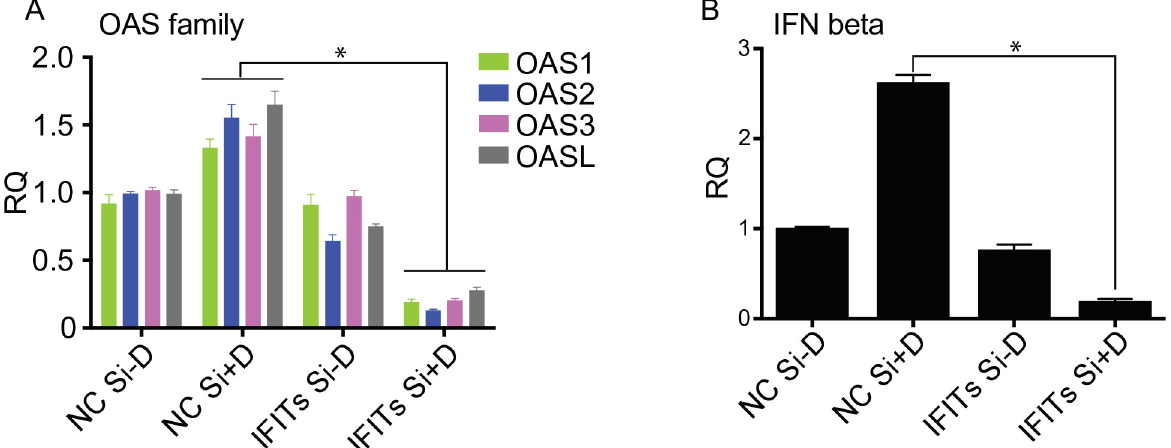
Fig 5. Effects of IFITs knockdown on expression of OAS family and IFN β . iSLK cells were depleted of IFIT1, IFIT2 and IFIT3 (IFITs) with siRNAs or transfected with negative control siRNA (NC Si). Cells were either untreated or treated with doxycycline induced to permit lytic KSHV replication. RNA was harvested at 48 h from each sample and qPCR was performed with primers specific for OAS1, OAS2, OAS3, OASL (A) or INF β (B). Expression of each mRNA (relative quantity, RQ) was normalized to the level of expression in uninduced control cells (NC Si-D). Each experiment was performed in biological triplicate and PCR was performed as technical triplicates. Error bars show SEM. � P <